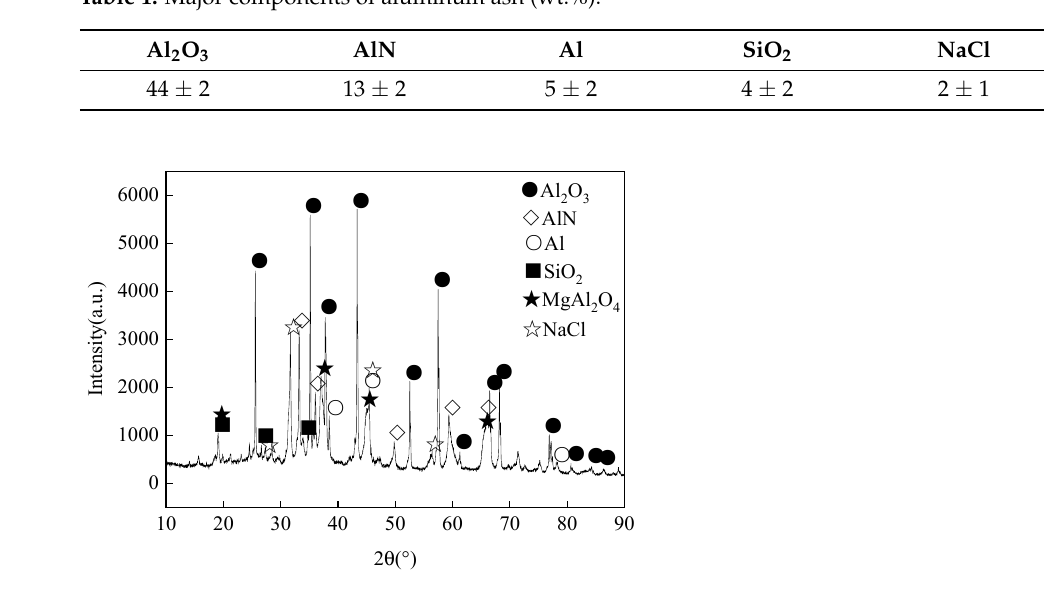
Figure 2. XRD pattern of aluminum ash.